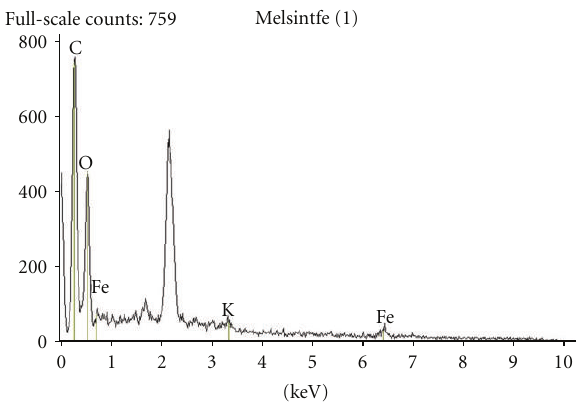
Figure 11: EDS analysis of Fe(III)-DHI.